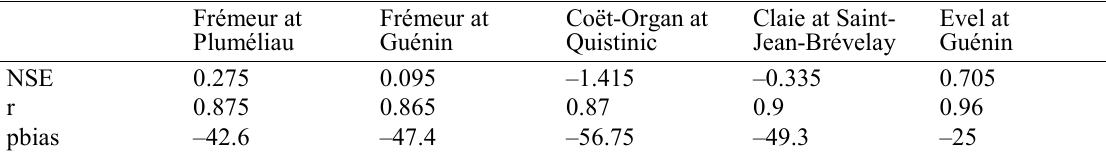
Table 1 Performance of simulations when transposing Coët-Dan at Naizin hydrograph to five surrounding basins. The median goodness of fit is presented for 12 periods of simulations of two months (Nov.–Dec. and May–June) between 2006 and 2012, using three different criteria: Nash-Sutcliffe efficiency (NSE), Pearson Correlation coefficient (r) and Percent Bias